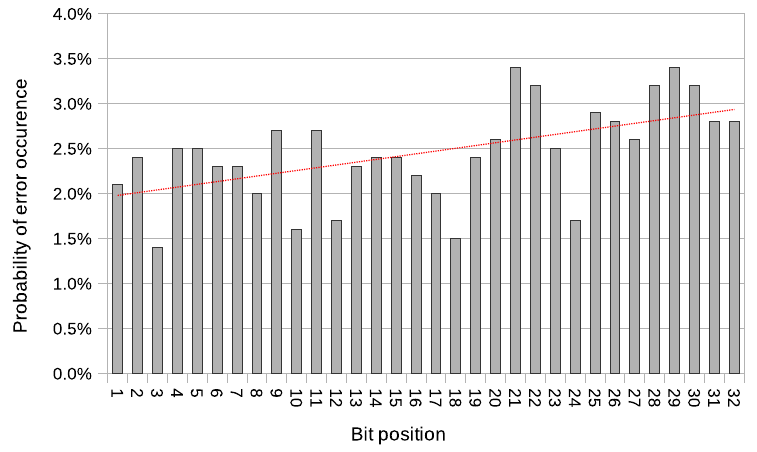
Figure 13. Probability of error occurrence as a function of bit position with a trend line (IEEE 802.11n;